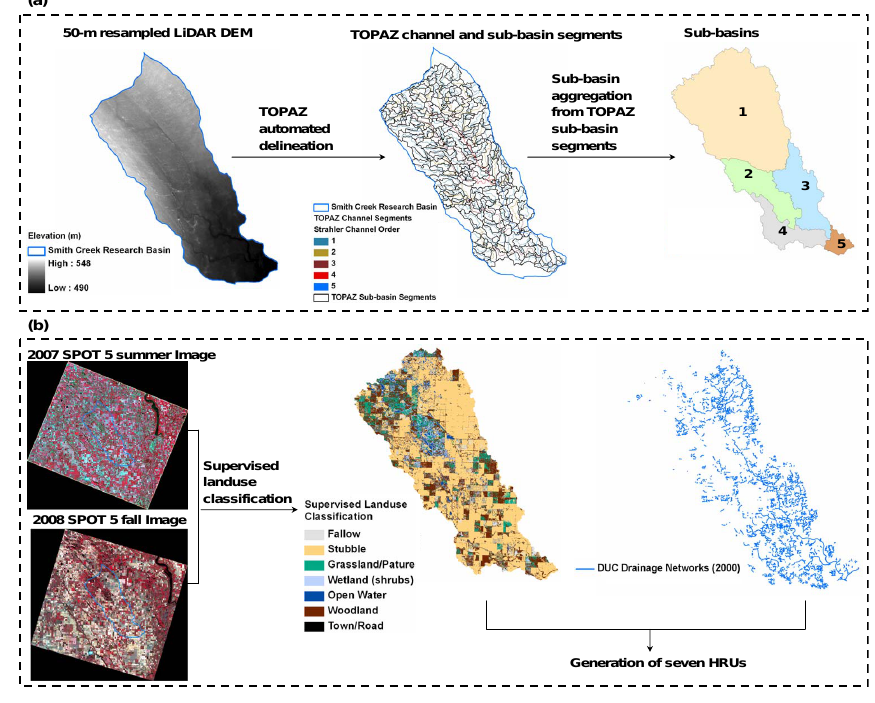
Fig. 5. Basin pre-processing procedures. (a) Smith Creek sub-basin generation from the TOPAZ basin delineation program using 50-m resampled LiDAR DEM and (b) Smith Creek HRU generation from Ducks Unlimited Canada drainage networks and supervised land use classification using SPOT 5 10-m multispectral